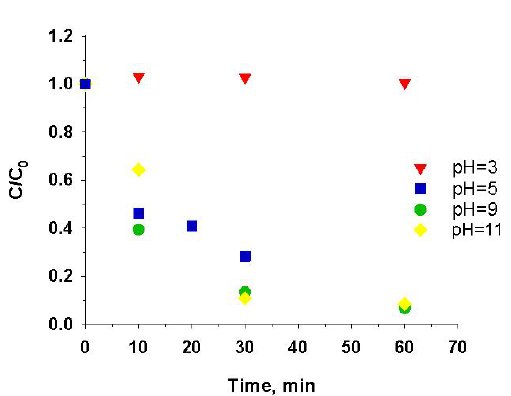
Fig. 9 MB removal efficiency at different solution pH levels. Reaction conditions: V= 50 ml, C